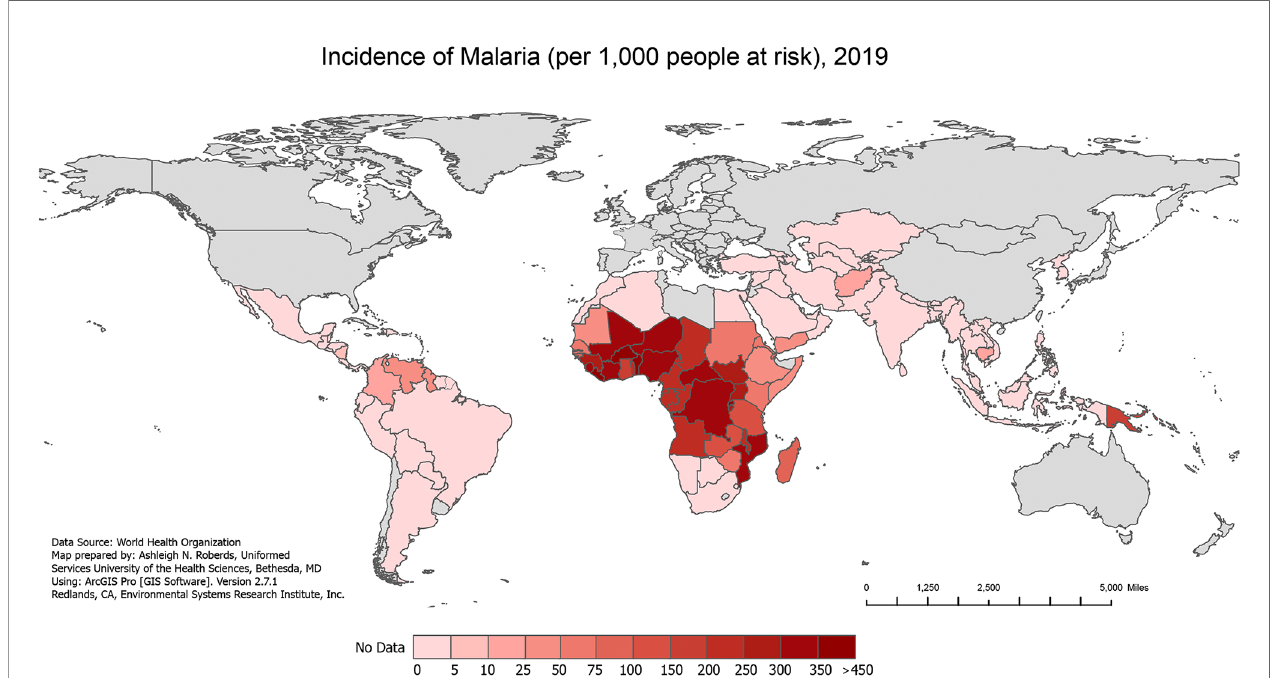
FIGURE 1 | Incidence of Malaria, 2019. The incidence of all malaria cases per 1,000 people at risk in 2019, extracted from the World Health Organization (WHO) 2020 World Malaria Report.